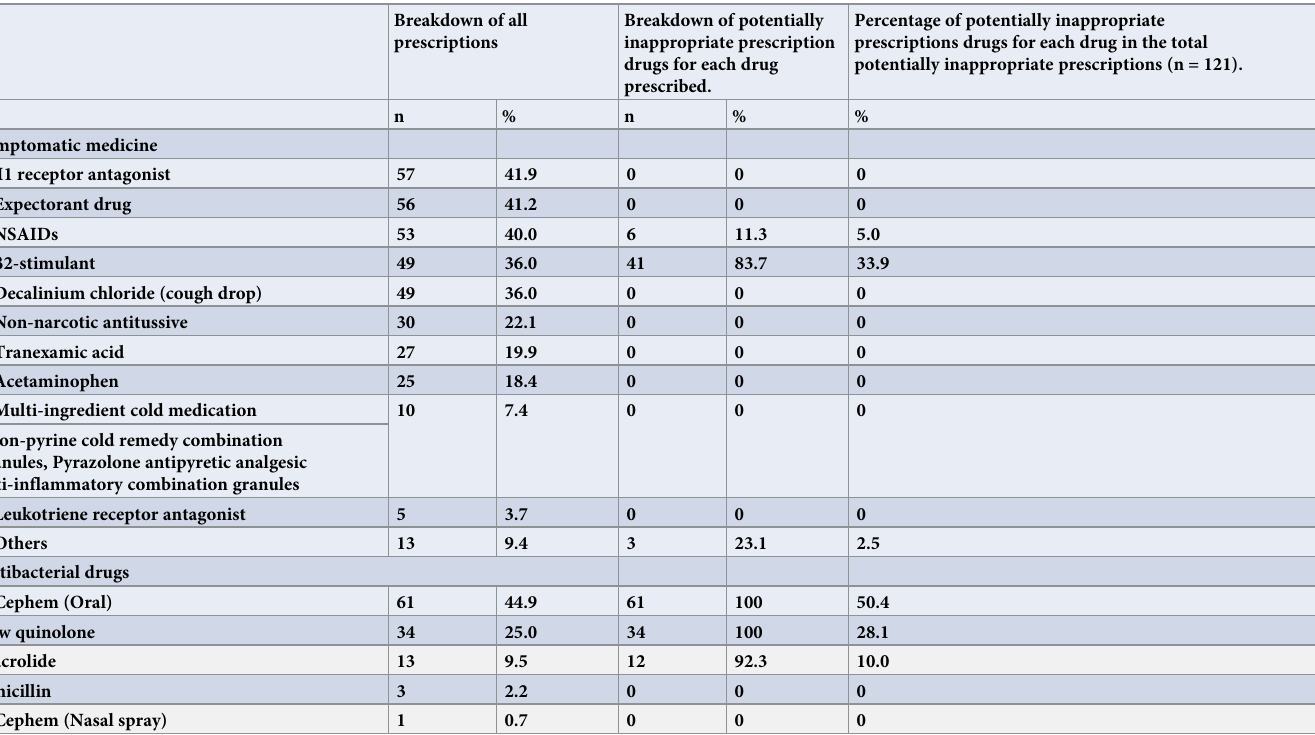
Table 3. Details of prescription drugs (n = 136).